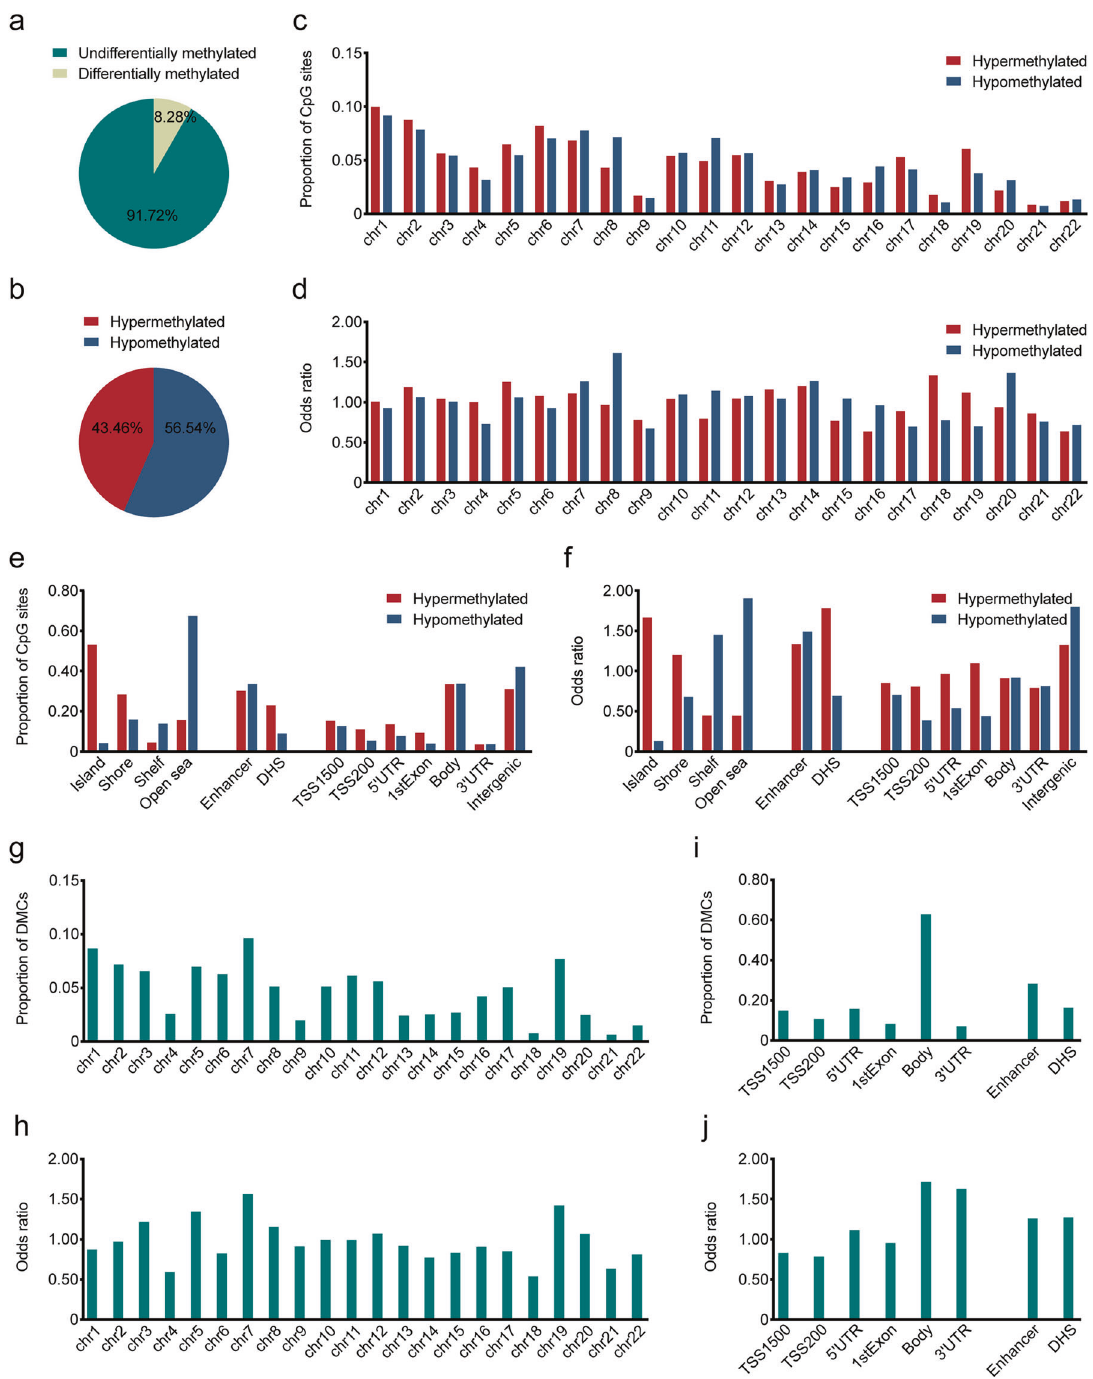
Fig. 1 Characteristics of differentially methylated probes in ESCC. a The proportion of all fi ltrated CpG sites that are differentially methylated or not methylated. b The proportion of differentially hyper-methylated (red) or hypo-methylated (blue) CpG islands. c , d The proportion ( c ) and odds ratio ( d ) of hyper-methylated (red) or hypo-methylated (blue) CpG sites in different chromosomes. e , f The category ( e ) and odds ratio ( f ) of genomic locations for hyper-methylated (red) or hypo-methylated (blue) sites. g , h The proportions ( g ) and odds ratio ( h ) of methylated CpG sites correlated with the expression levels of genes in different chromosomes. i , j The category ( i ) and odds ratio ( j ) of genomic locations for CpG sites correlated with genes expression. Odds ratio was computed against the general distribution and P value was computed by Hypergeometric test. Island, CpG island; shore, 0 – 2 kb from CpG island; shelf, 2 – 4 kb from CpG island; open sea, other genomic regions; TSS1500, 200 – 1500 bases upstream of the transcriptional start site (TSS); TSS200, 0 – 200 bases upstream of the TSS; 5 ’ UTR, within the 5 ’ untranslated region and between the TSS and the ATG start site; body, between the ATG and stop codon regardless the presence of introns, exons, TSS or promoters; 3 ’ UTR, between the stop codon and poly A signal